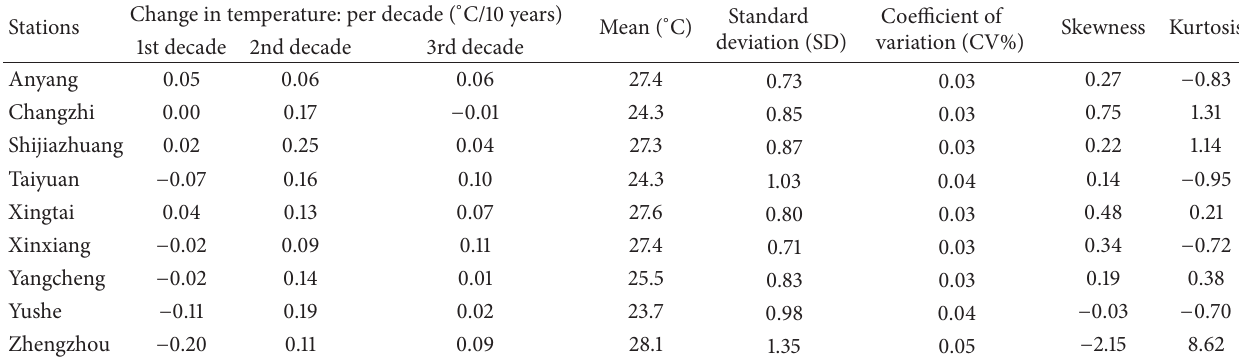
Table 2: Statistical results of mean temperature during